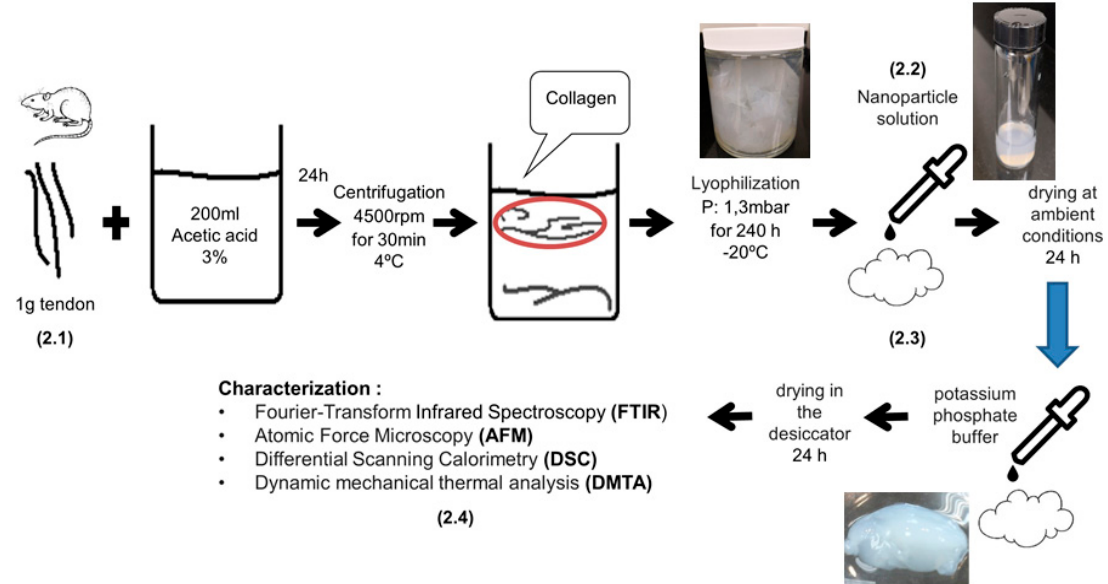
Figure 1. Schematic of experimental procedures followed during the preparation of collagen scaffolds impregnated with propolis nanoparticles and the corresponding characterization techniques.